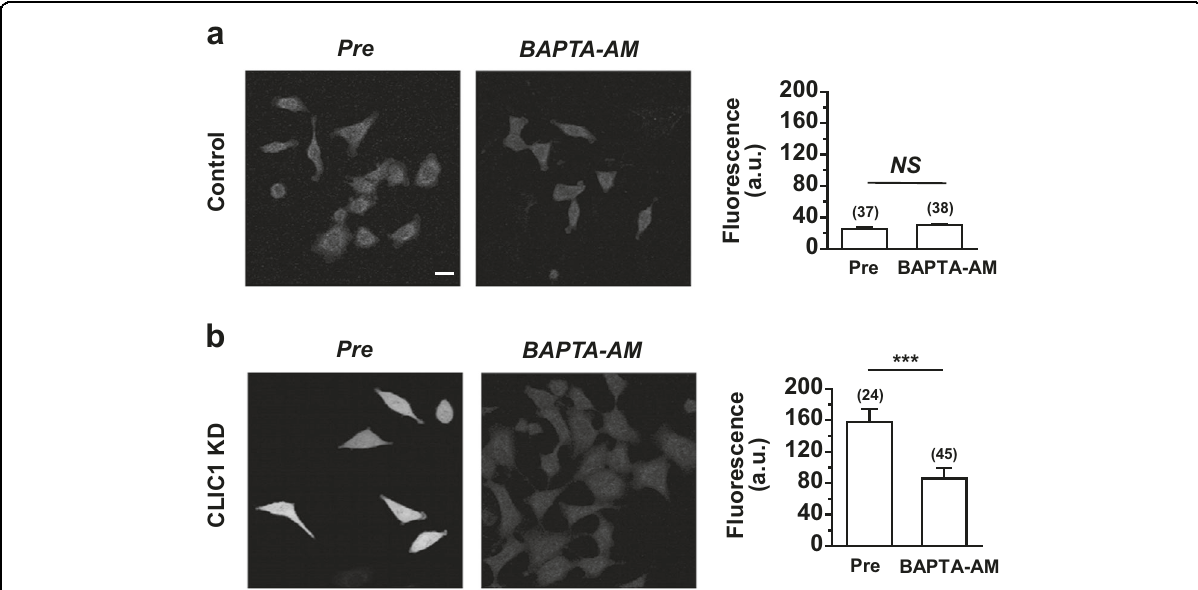
Fig. 4 The increase in ROS levels in CLIC1-knockdown cells is rescued by BAPTA-AM. a, b Left, The level of ROS formation was measured in control ( a ) and CLIC1 KD A549 cells ( b ) pretreated with BAPTA-AM. Scale bars, 20 μ m. Right, Summary bar graphs showing ROS levels in control and CLIC1 KD A549 cells in the absence and presence of BAPTA-AM. Means ± SEMs. *** P < 0.005 by Student ’ s t -test. NS , not signi fi cantly different